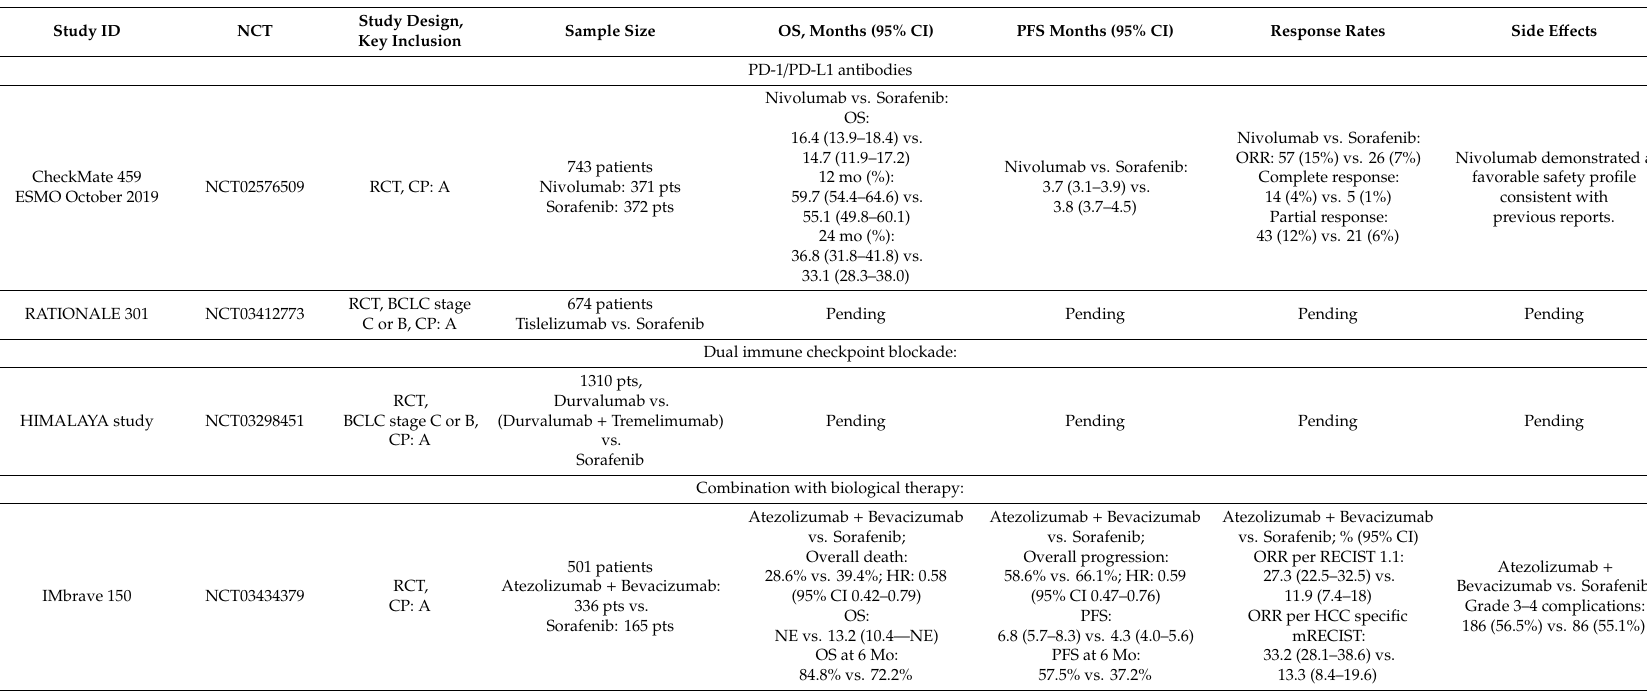
Table 1. Immune checkpoint inhibitors as first-line therapy for unresectable hepatocellular carcinoma